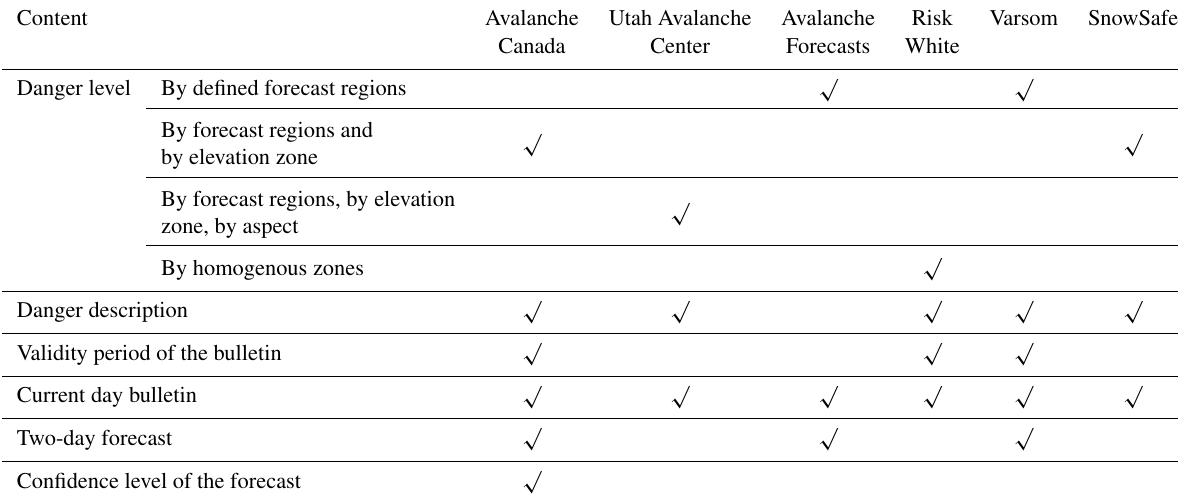
Table 2. Content available in smartphone applications: danger level and related information. the given smartphone application.